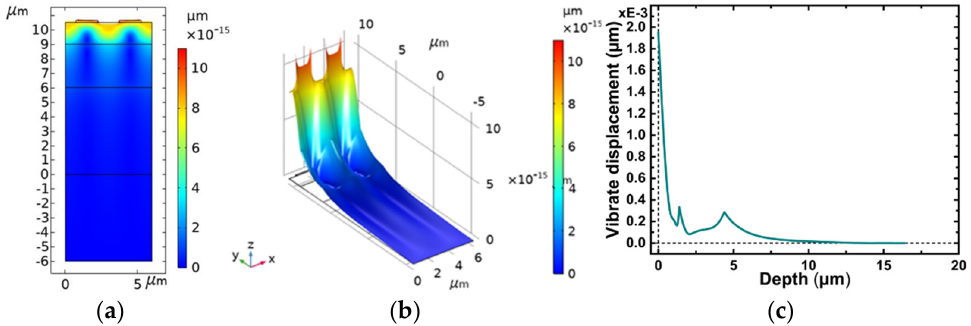
Figure 4. Plot of the displacement versus substrate depth of the proposed device at Rayleigh mode. ( a ) is a two-dimensional result and ( b ) is a three-dimensional result ( c ) is the calculated displacement of acoustic waves in depth direction.